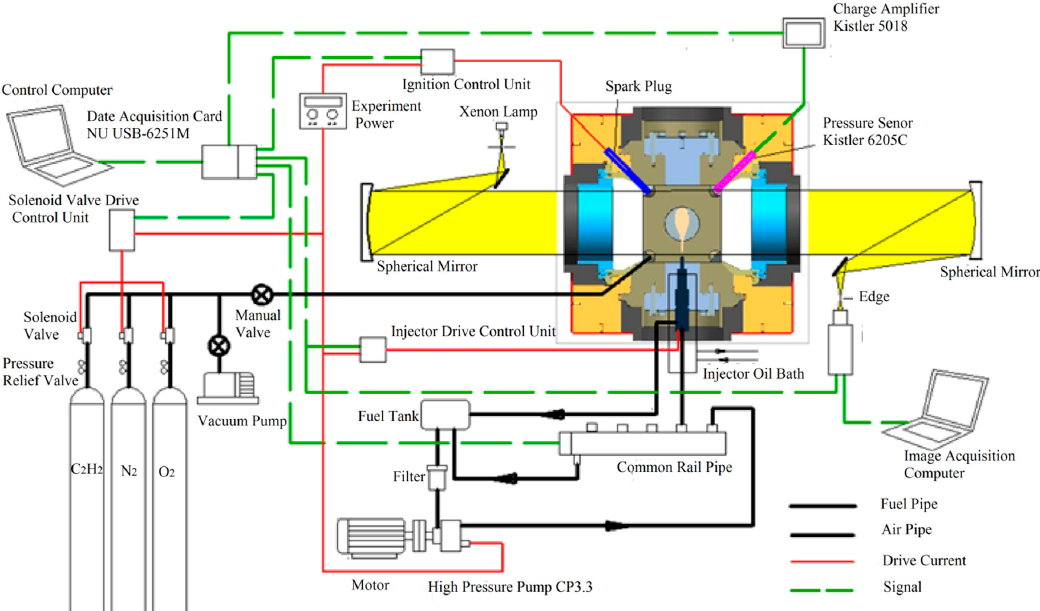
Figure 1. Schematic of the constant volume chamber optical system.